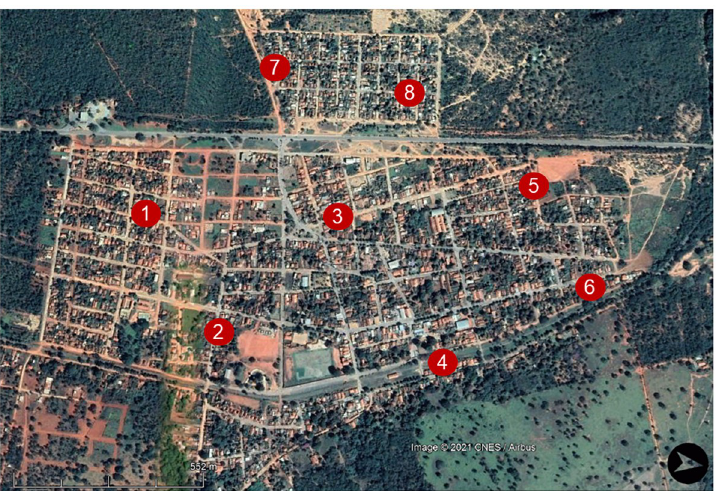
Fig 3. Distribution of sampling points in the study area of Lassance, Minas Gerais, Brazil. Red dots with numbers (1–8) identify the sampling points.